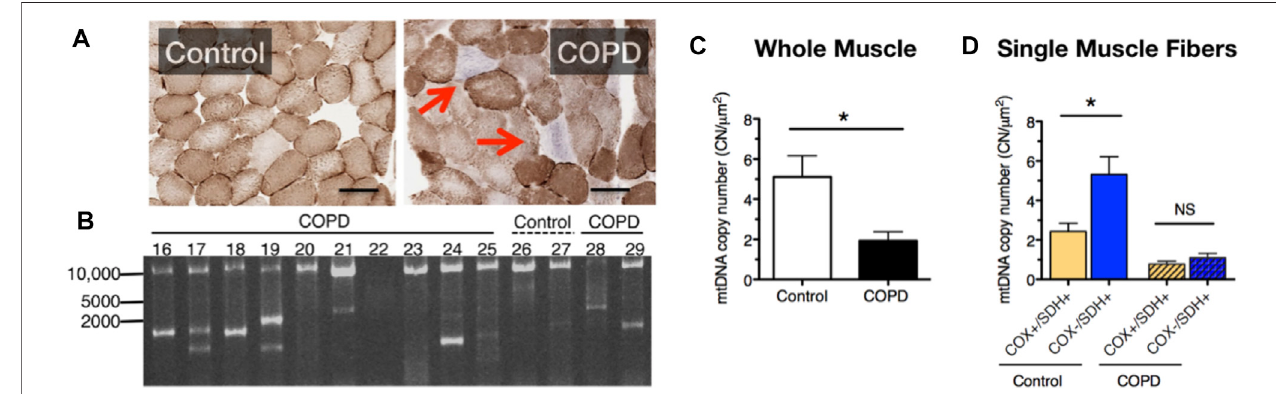
FIGURE 2 | COPD patient muscle evidences (A) an increased accumulation of muscle fi bers with respiratory impairment ( fi bers indicated by the red arrows lack cytochrome oxidase activity), (B) accumulation of mtDNA deletion mutations, (C) reduced mtDNA copy number, and (D) an impaired up-regulation of mtDNA copy number in response to energetic stress in muscle fi bers with respiratory impairment. Images and data in panels (B – D) are adapted from (Konokhova et al., 2016).